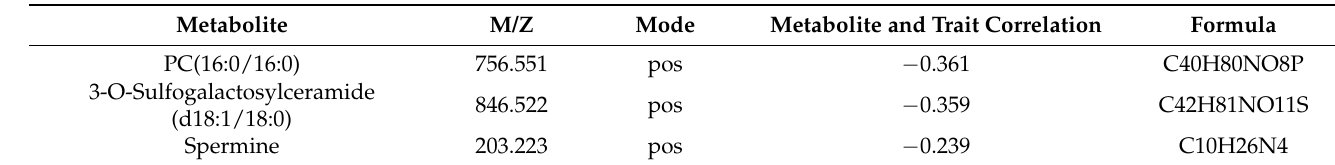
Table 2. The three metabolites in the MEblue module of positive mode obtained by KEGG pathway annotation.